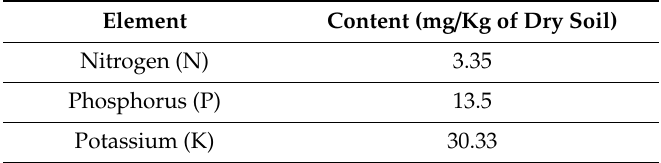
Table 2. Information about the mineral content of the sandy soils used in this study.